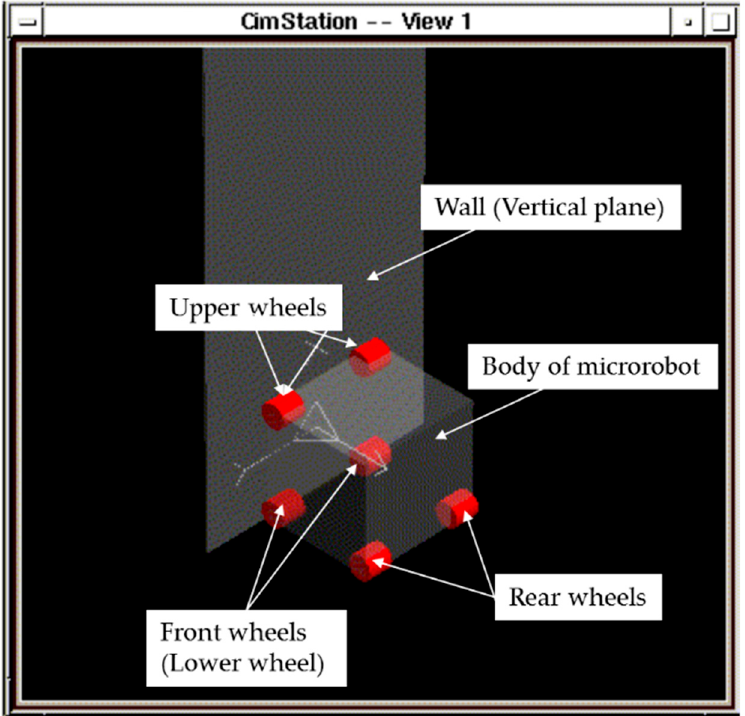
Figure 1. Six-wheeled model of a microrobot. This model has four magnetic wheels in the horizontal plane and four magnetic wheels in the vertical plane. The front wheels (lower wheels) are the driving wheels, and the rear and upper wheels are the driven wheels.